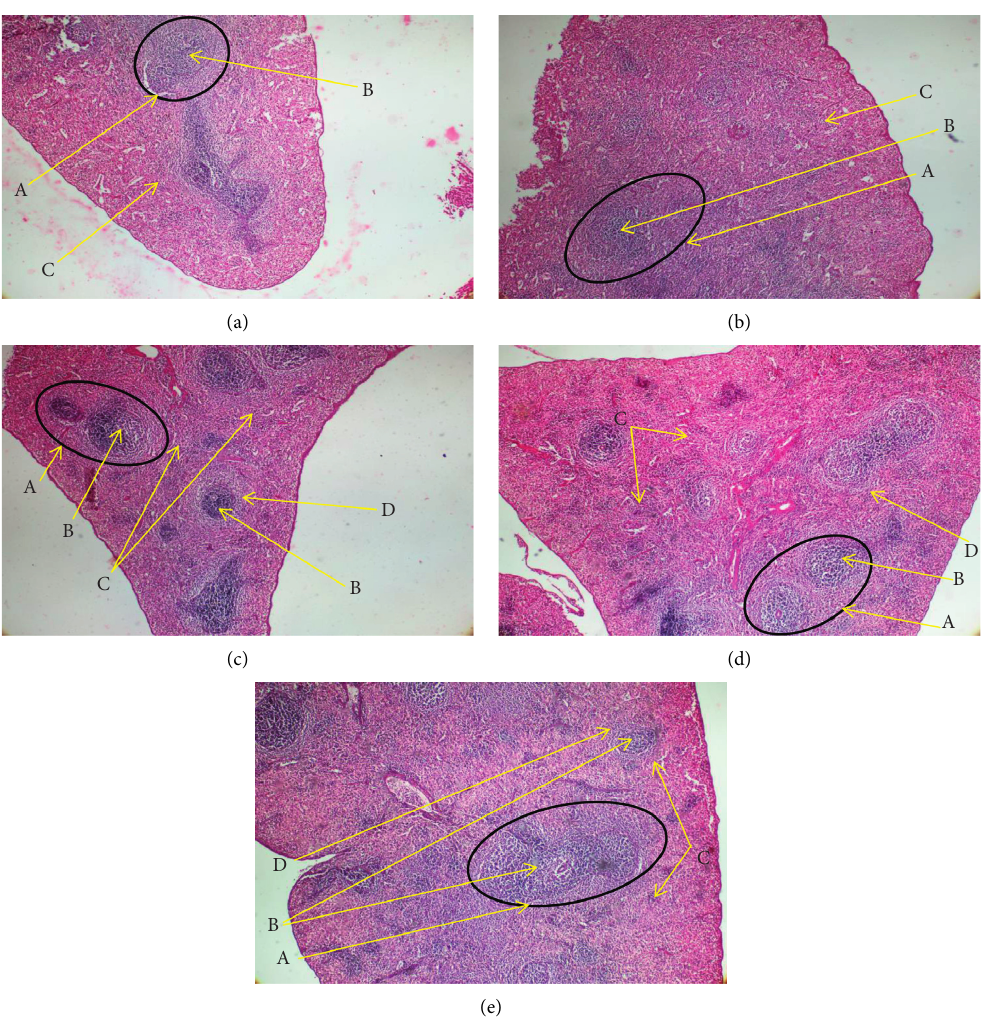
Figure 4: Microarchitecture of rat spleen of different groups (control and extract-treated groups). Normal group: untreated animals; negative: animals receiving methylprednisolone only. (a) Cross section of a rat spleen of control group showing the white pulp of the spleen with germinal center (B) and the red pulp (C) (H&E, X 100). (b) Cross section of a rat spleen of negative group showing white pulp (A) with poor germinal center (B) and the red pulp (C) (H&E, X 100). (c) Cross section of a rat spleen of 25mg group showing white pulp (A) with very dense germinal center (B), marginal zone (D), and the red pulp (C) (H&E, X 100). (d) Cross section of a rat spleen of 50mg group showing white pulp (A) with dense germinal center (B), marginal zone (D), and the red pulp (C) (H&E, X 100). (e) Cross section of a rat spleen of 50mg group showing white pulp (A) with dense germinal center (B), marginal zone (D), and the red pulp (C) (H&E, X